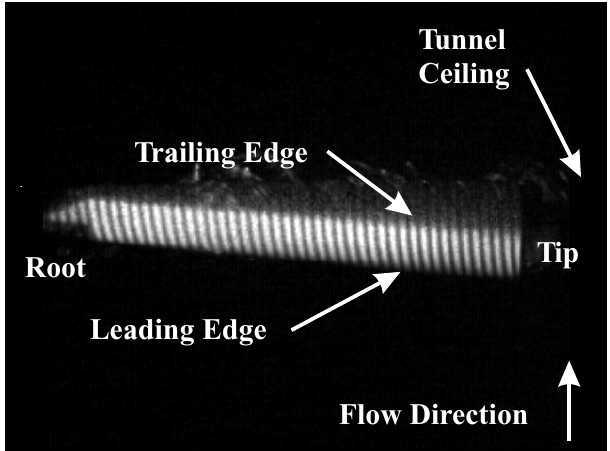
Fig. 8. Rotor blade geometry within PMI